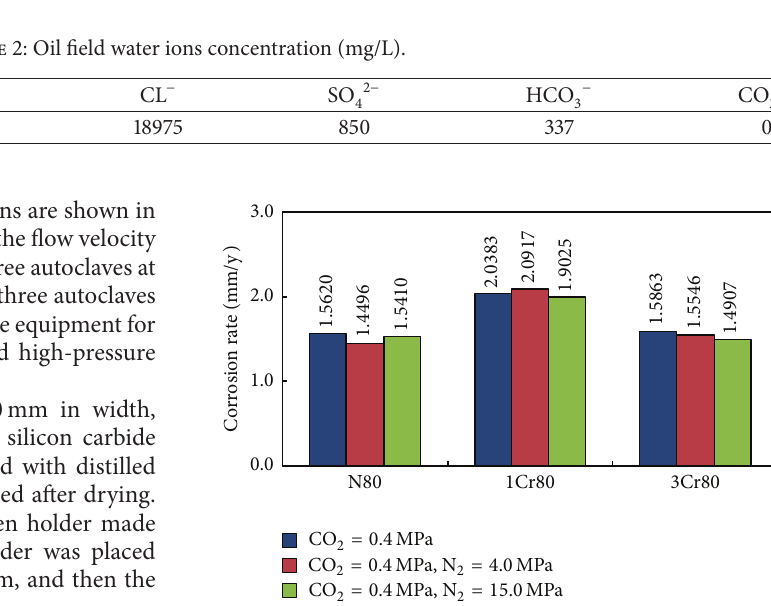
Figure 2: Corrosion rates contrast under different total